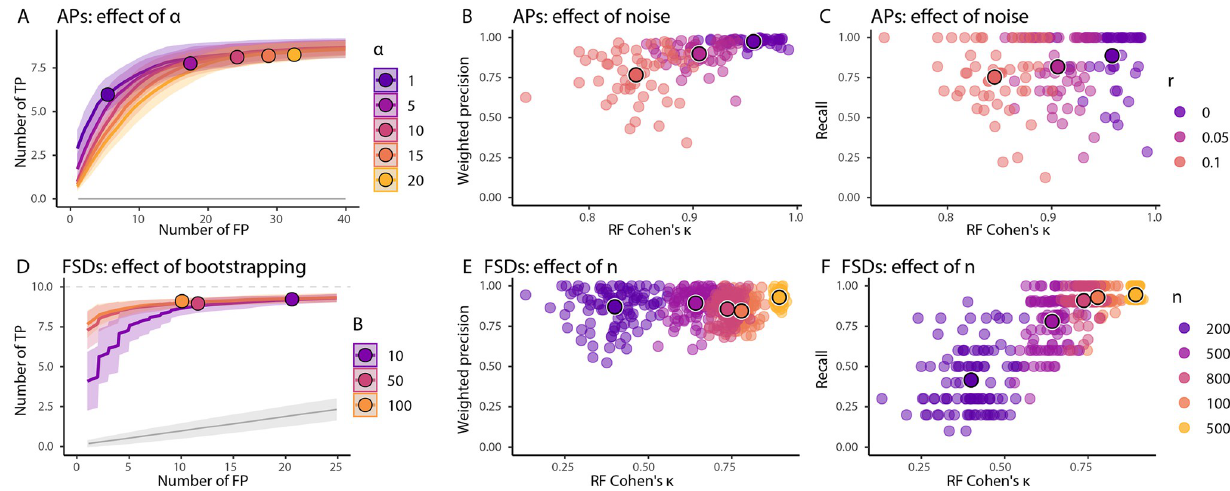
Fig 3. endoR’s performance is robust to hyperparameters and depends on the input model. Simulation results based on 100 FSDs with n = 1000 observations (except when varied in E-F) and 50 APs using all observations (A-C). In all experiments, the noise was r = 0.05 (except when varied in B-C) and endoR was applied to fitted RFs with α = 5 (except when varied in A) and B = 10 (except when varied in D). For each dataset and parameter setting we fitted a RF and applied endoR. Then, we computed the following three metrics: Cohen’s κ of the RF, weighted precision and recall values of the selected edges in the stable decision ensemble, and TP/FP-curves based on the probabilities of being selected in the stable decision ensemble (see Methods). A and D: TP/FP-curves are averaged across all datasets for a fixed parameter setting (line) and standard deviation (shaded area) are displayed. The average number of TPs and FPs expected for a randomization null model and standard deviations, are shown in grey. Large points indicate the average number of TPs and FPs in the stable ensembles generated by endoR. B-C and E-F: Each point corresponds to the precision/recall of endoR applied to a single dataset and parameter setting. The larger traced points are the averages across all datasets for a fixed parameter setting. A: Increasing α increases both the TPs and FPs. Small values of α effectively control the FPs without strongly impacting the recovered TPs. D: Larger values of B are slightly better but endoR performs well even for small values of B . B-C and E-F: As expected decreasing the noise or increasing the number of observations improves the performance of endoR both in terms of precision and recall. Importantly, there is a strong dependence of endoR performance on the performance of the fitted RF. Moreover, endoR has a good precision even for small sample